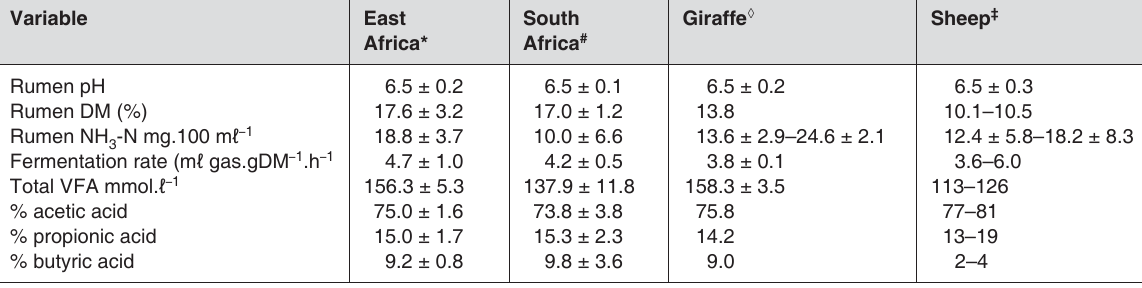
TABLE 5 The composition of rumen fluid in wild ruminants and sheep